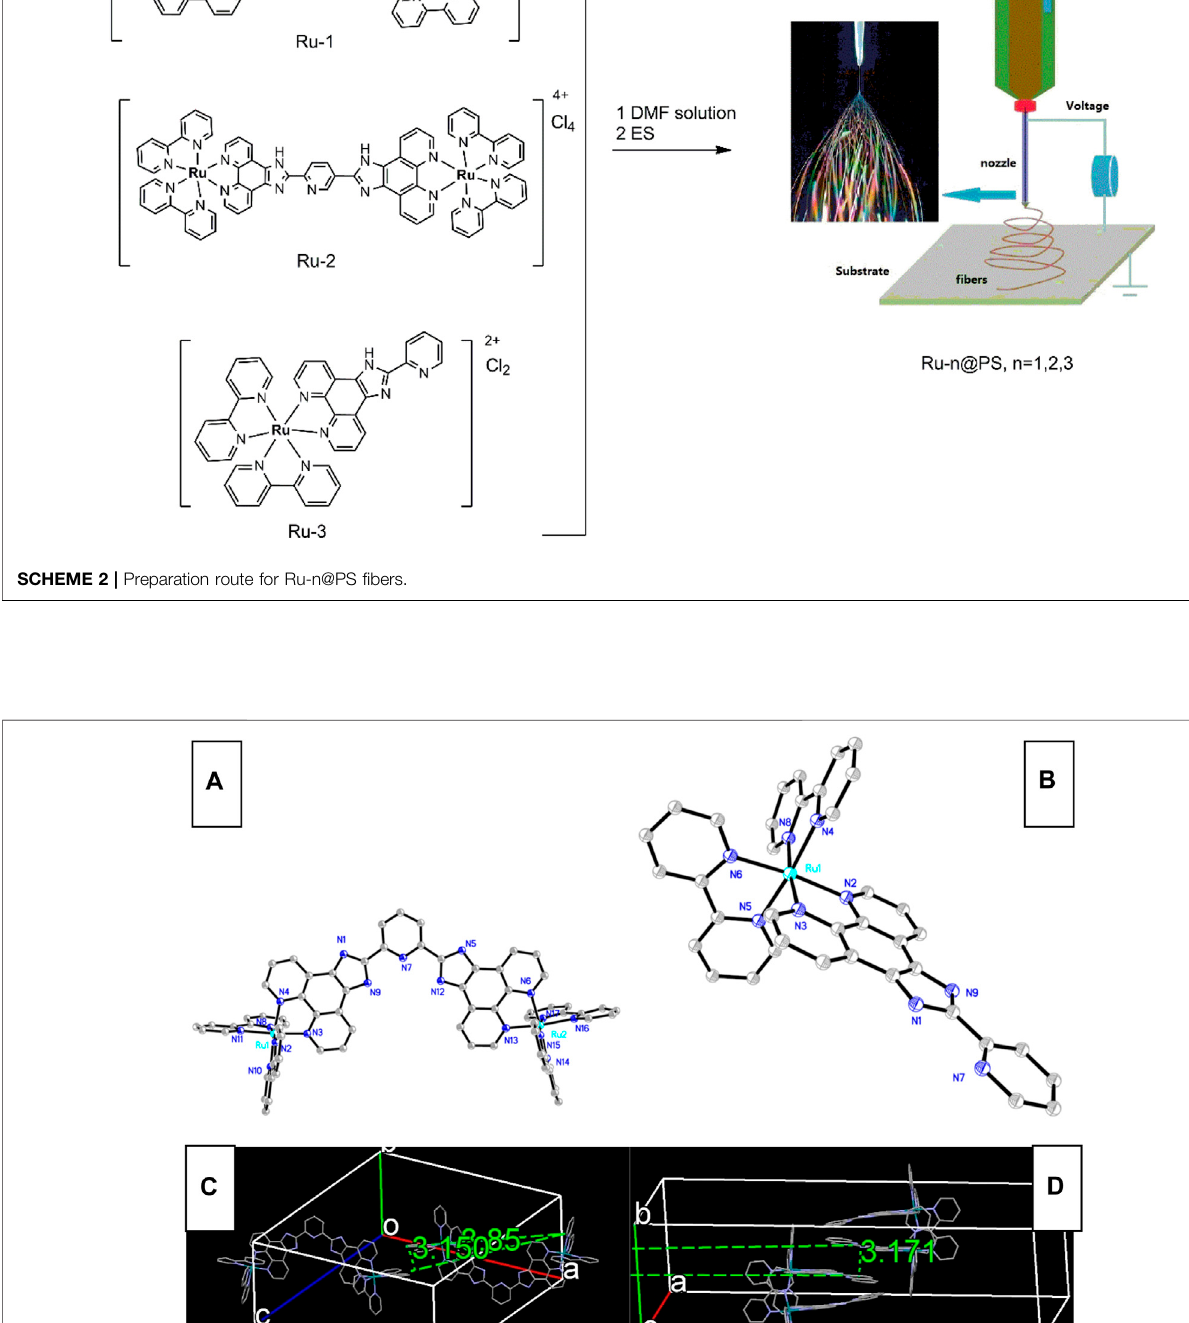
Frontiers in Chemistry |